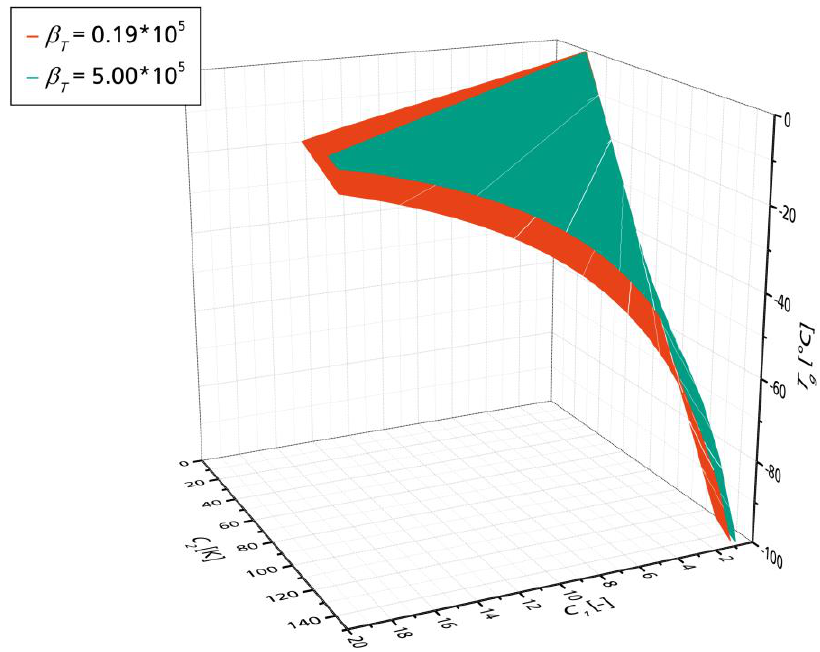
Figure 4. Plots of Equation (4) using T 0 = +10 °C and impact frequencies of 0.19 × 10 5 and 2.0 × 10 5 Hz.